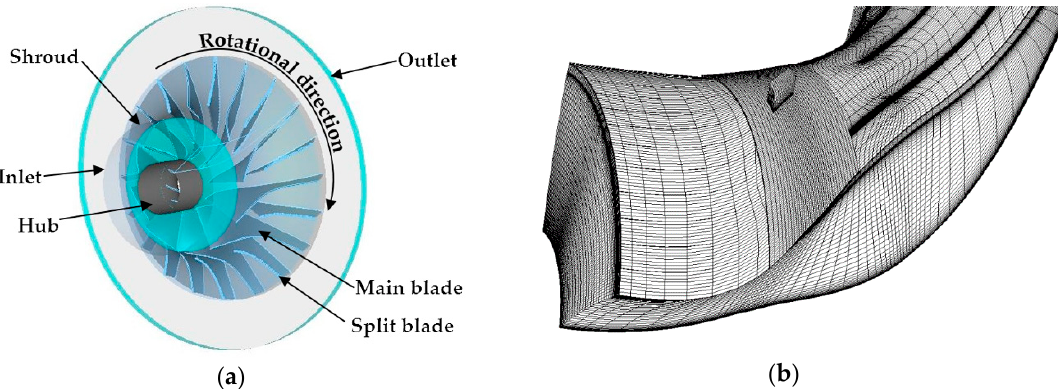
Figure 1. The three-dimensional centrifugal compressor and its simulation domain: ( a ) The investigated three-dimensional centrifugal compressor; ( b ) the simulation domain and its grid.